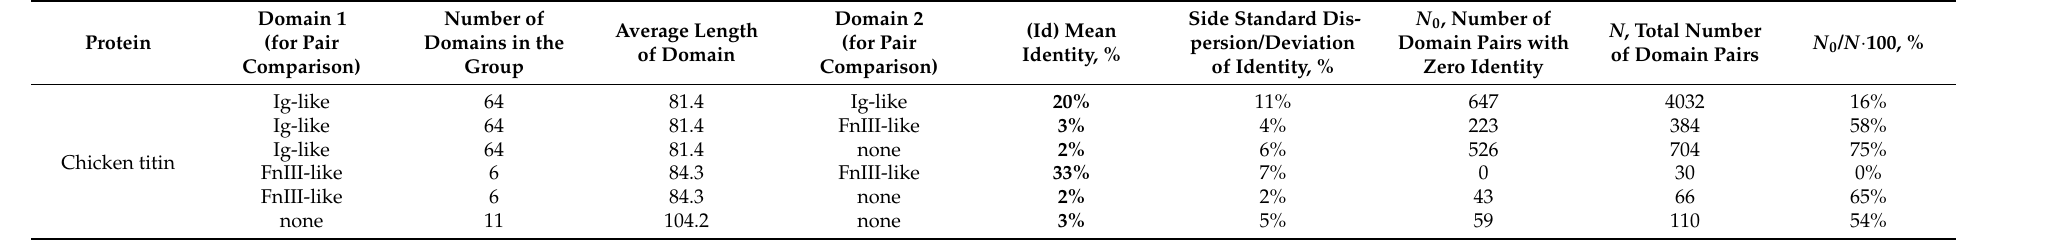
Table 2. Identity of the chicken-titin amino acid